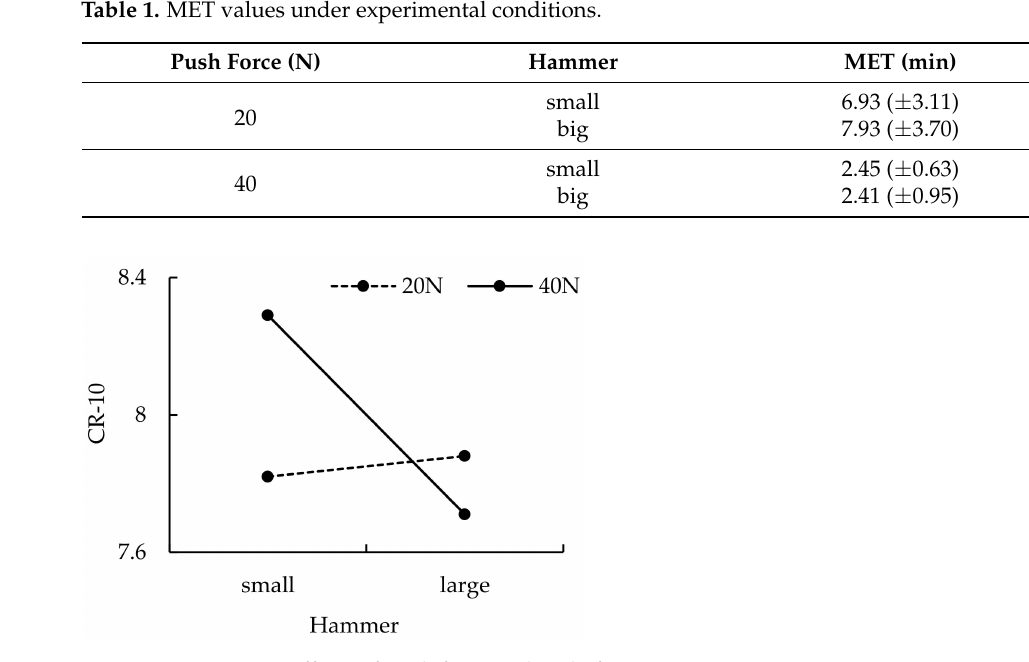
Figure 3. Interaction effects of push force and tool of CR-10 0